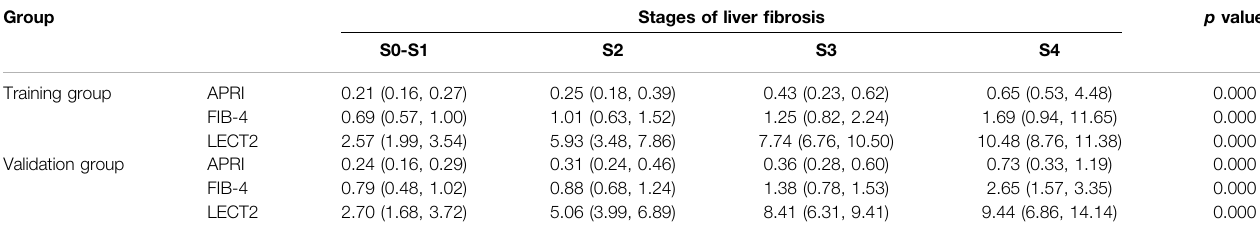
TABLE 2 | Levels of APRI, FIB-4 and LECT2 in different stages of liver fi brosis in the training group and validation group. Group